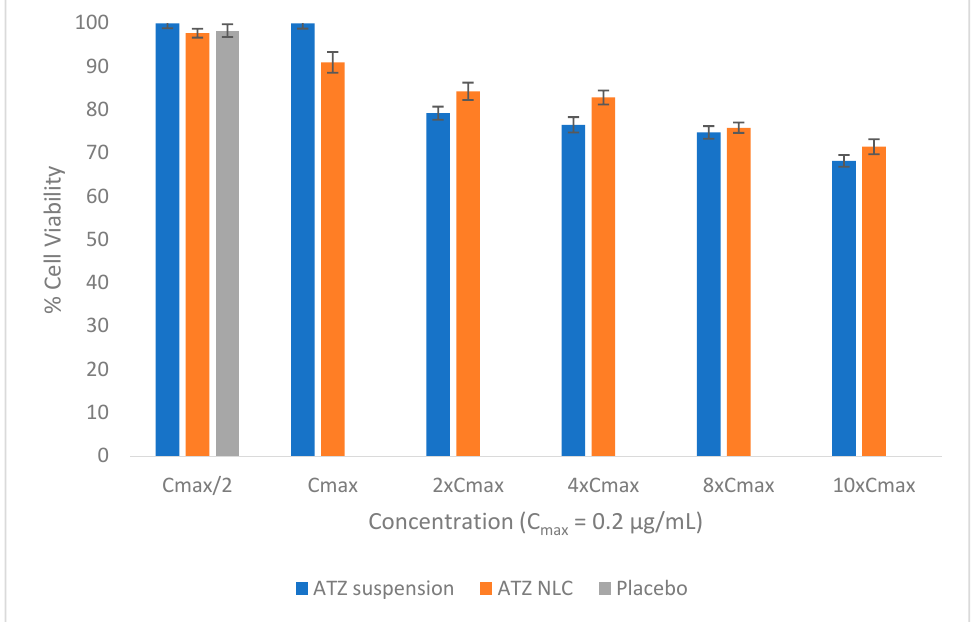
Figure 8. % Cell viability at different C max levels.